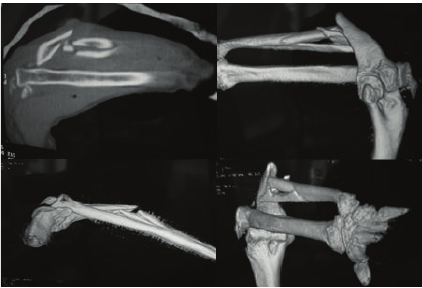
Figure 2: CT-scan with 3D reconstruction.